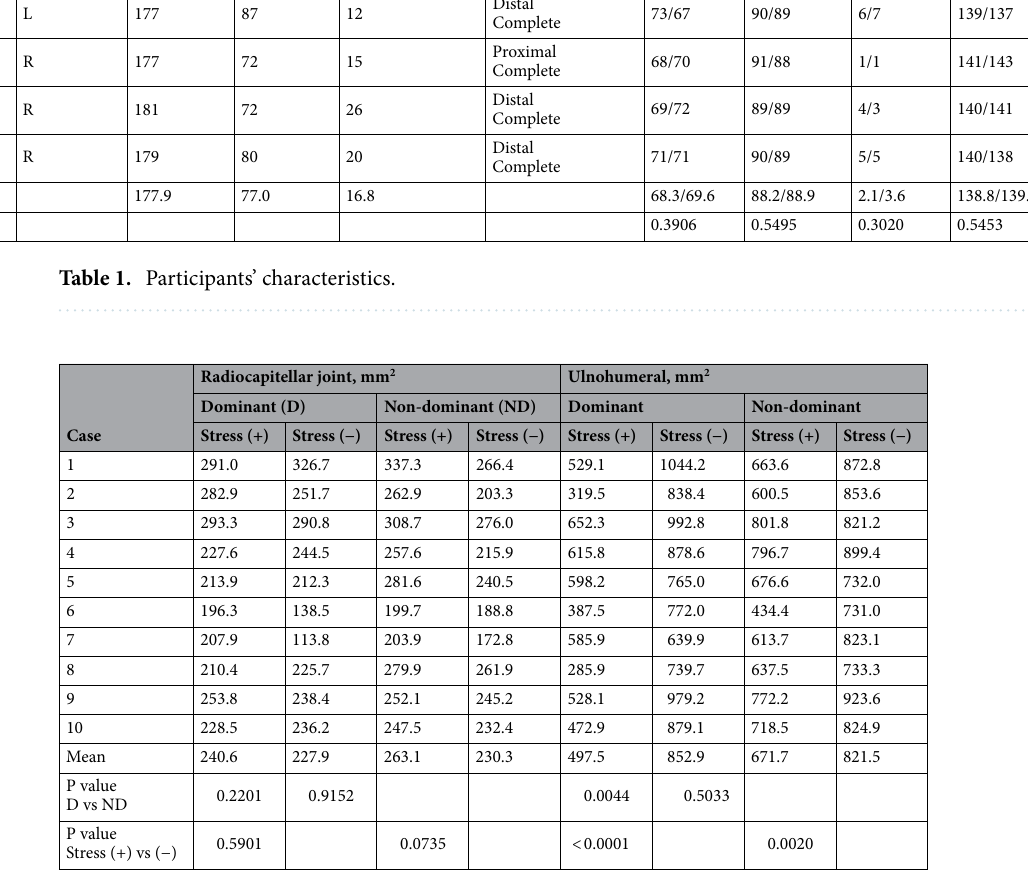
Table 2. Elbow joint contact